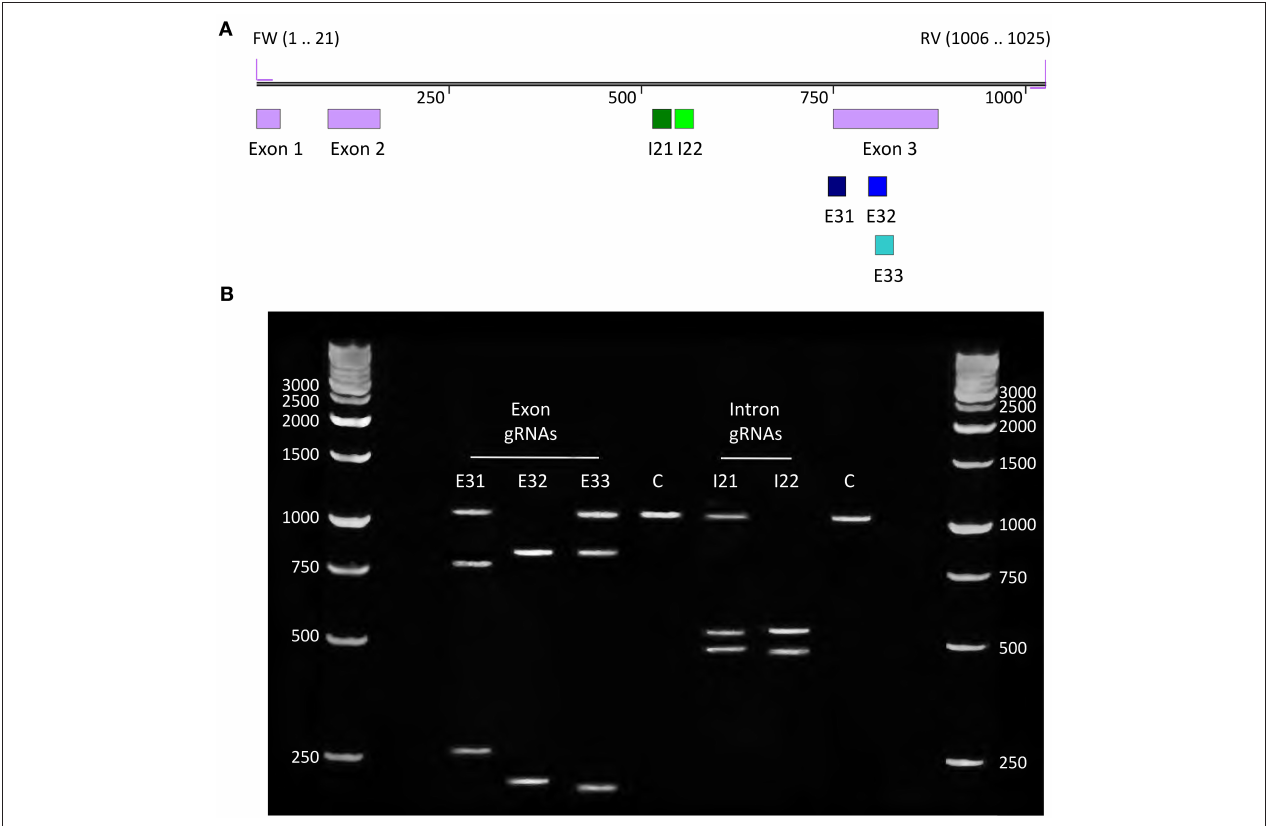
FIGURE 3 | gRNA design & in vitro assay. (A) Sequence map showing locations of gRNAs on the OAS1Ab wild-type PCR product of 1,025 bp. (B) Gel electrophoresis results of the in vitro assay to determine how efficiently 5 gRNAs can direct Cas12a to cleave their respective target sites in the 1,025 bp wild-type PCR product. Most gRNAs partially degraded the target DNA, resulting in 3 visible bands (the full-length PCR product and the 2 cleavage products). gRNA E32 and I22 fully degraded the DNA, leaving only their 2 cleavage products as visible bands, and these gRNAs were selected to edit the G. barretti OAS1Ab